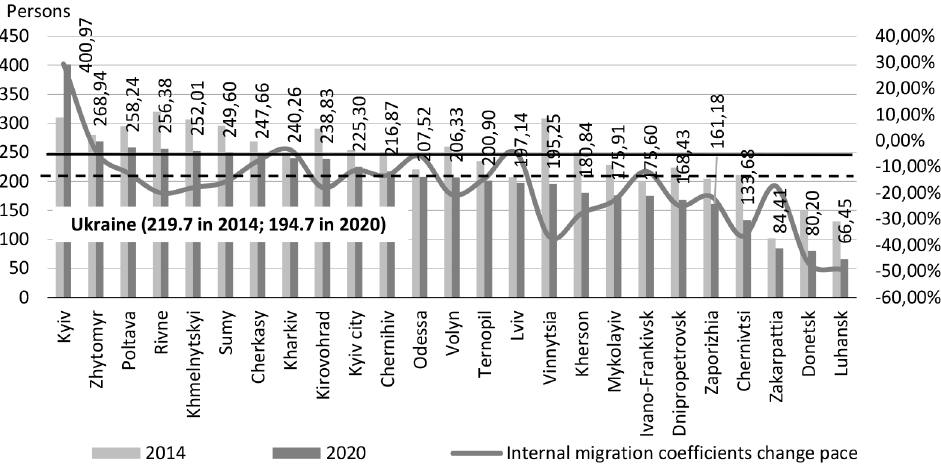
Figure 1. Internal migration in Ukraine; regional breakdown for 2014 and